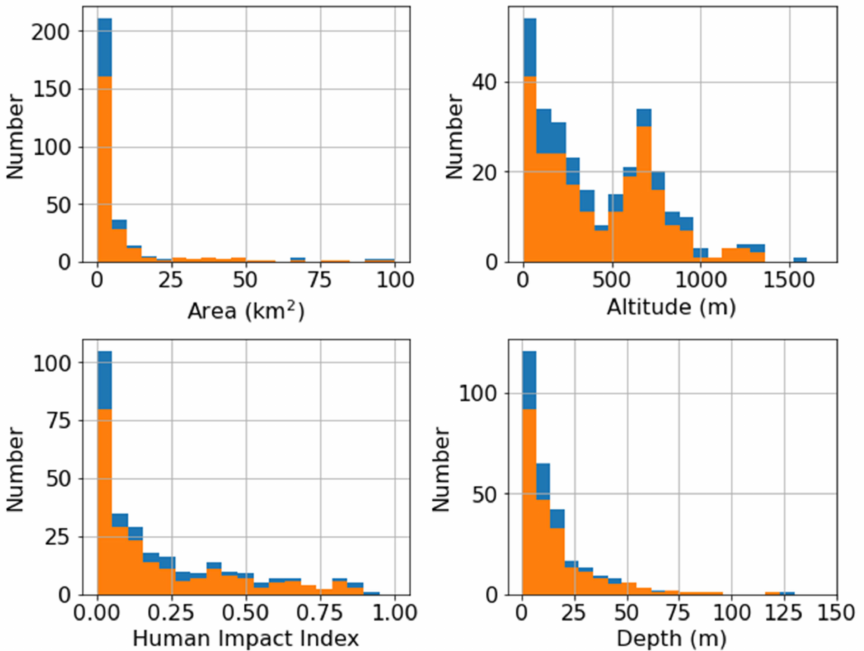
Figure 2. Distribution of the basic features (area, altitude, Human Impact Index and depth) of the sampled lakes that have the optical measurements (blue) and matchups